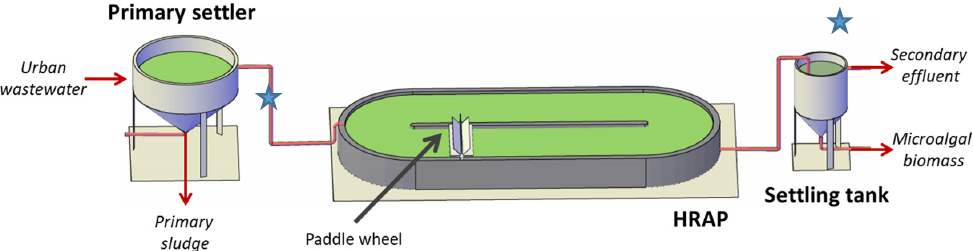
Figure 1. Diagram of the high rate algal pond (HRAP) pilot plant used in the study. Samples were taken after the primary settler and after the secondary settler (indicated with a star).